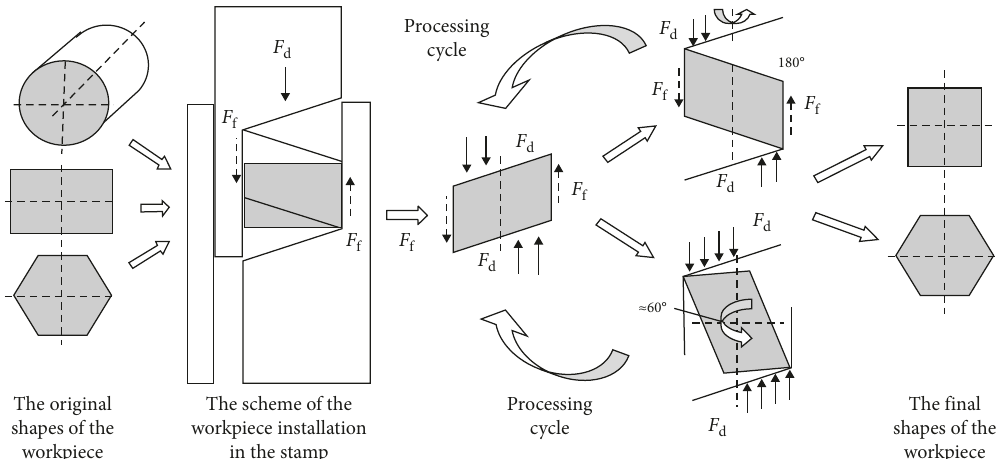
Figure 4: Various processing routes (RS-180 and RS-60) for the reverse shear scheme (RS)